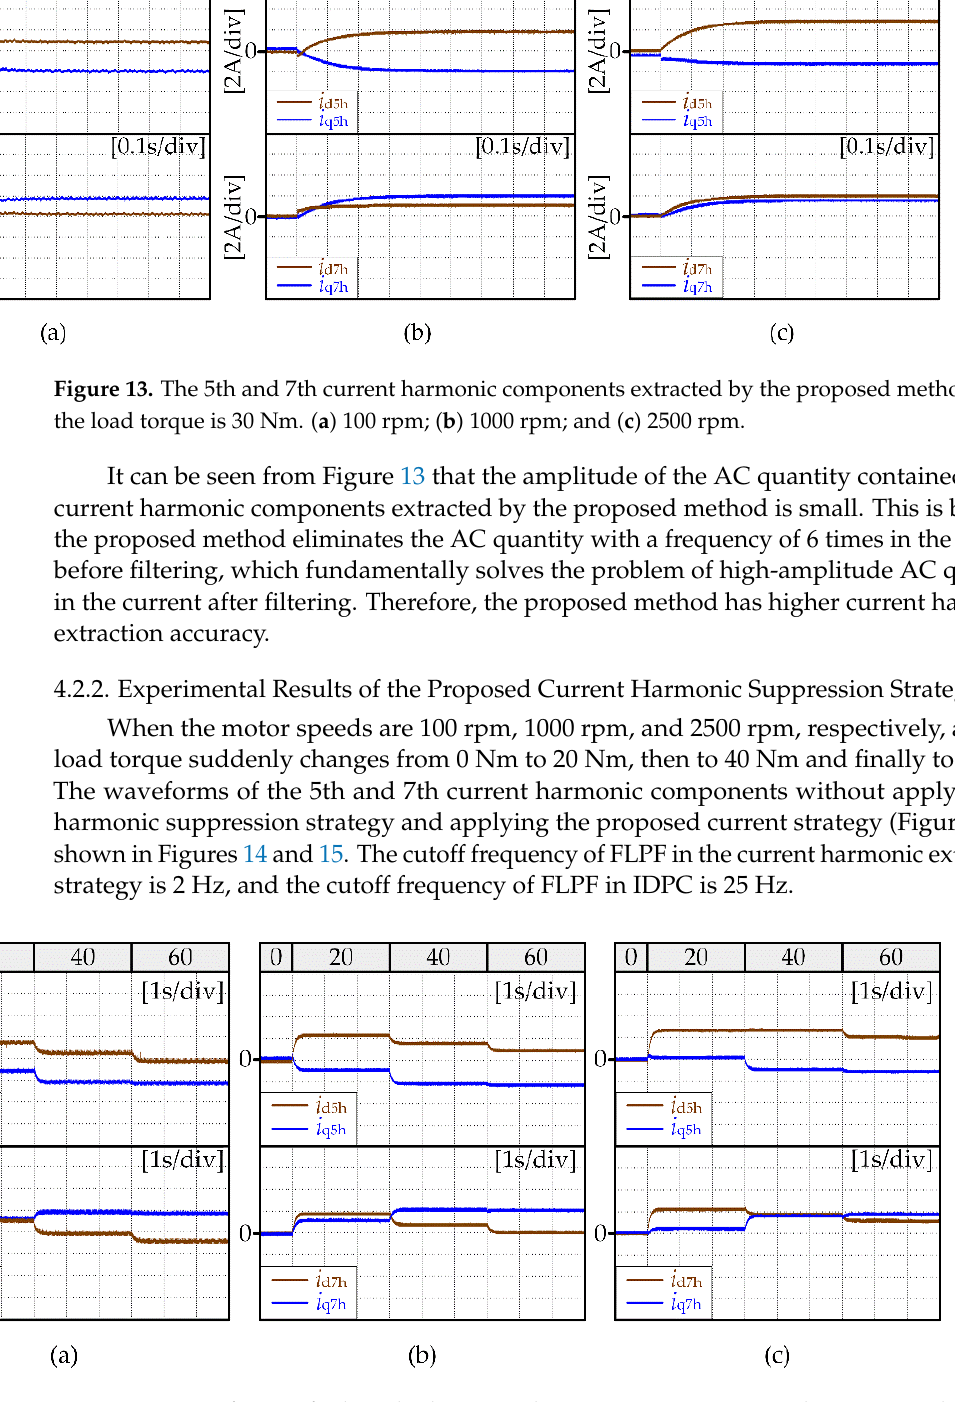
Figure 12. The 5th and 7th current harmonic components extracted by the traditional method when the load torque is 30 Nm. ( a ) 100 rpm; ( b ) 1000 rpm; and ( c ) 2500 rpm.